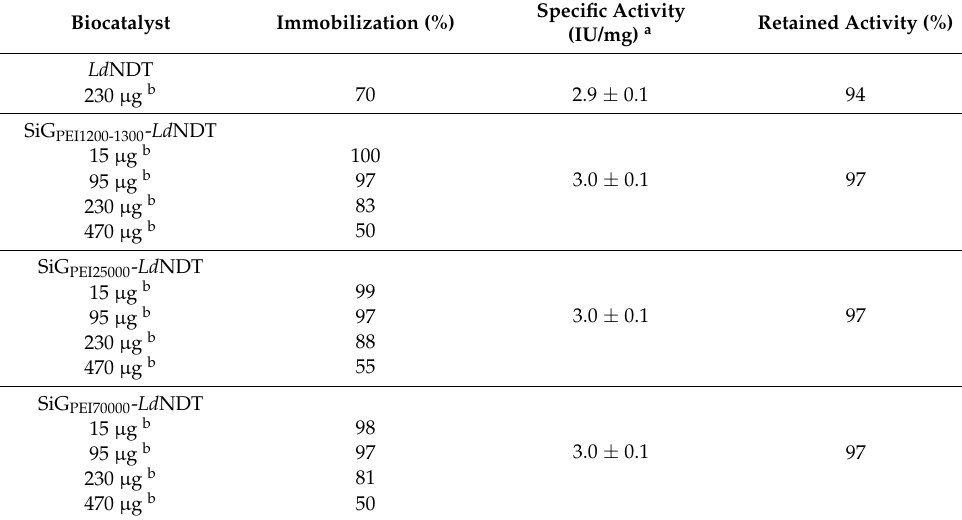
Table 1. Covalent immobilization of Ld NDT onto different supports